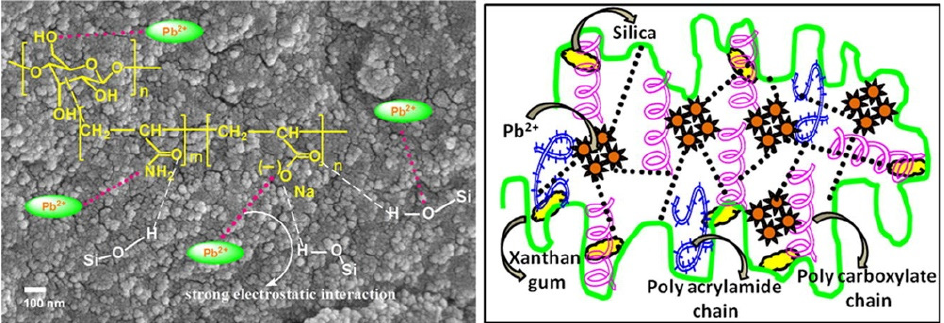
Figure 5. Morphology and structure of xanthan gum- g -poly(acrylamide)/nano silica composite adsorbent and its adsorption mechanism for Pb(II) ion